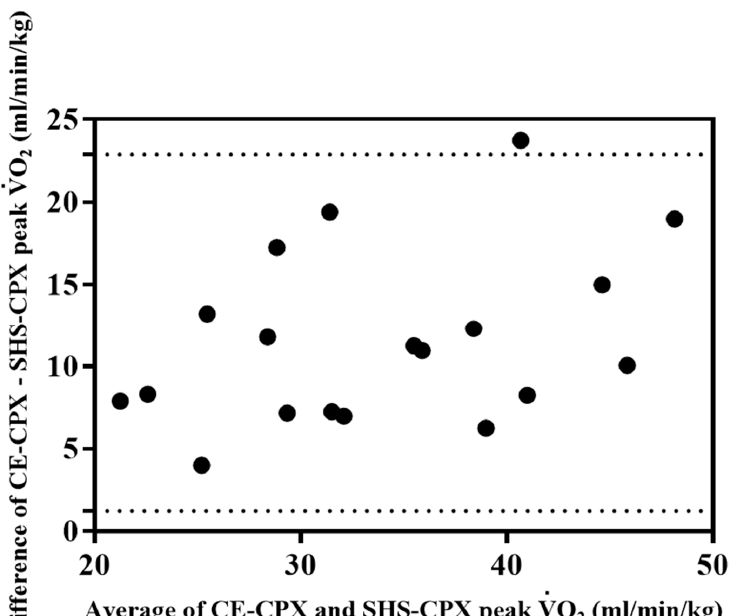
Figure 2. Graph showing the correlation between peak V tained during SHS-CPX. CE-CPX: cycle ergometer cardiopulmonary testing; SHS-CPX: sitting and handshaking exercise cardiopulmonary testing; V